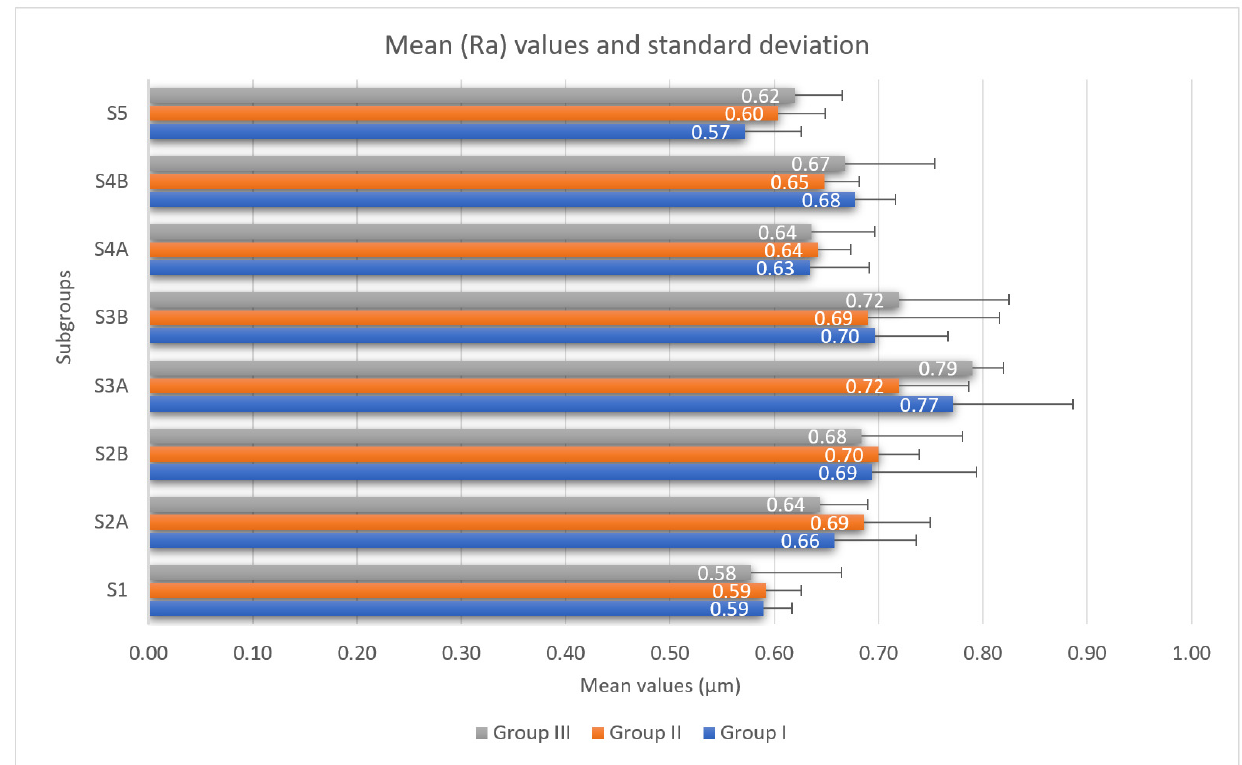
Figure 3. Mean (Ra) values and standard deviation for each